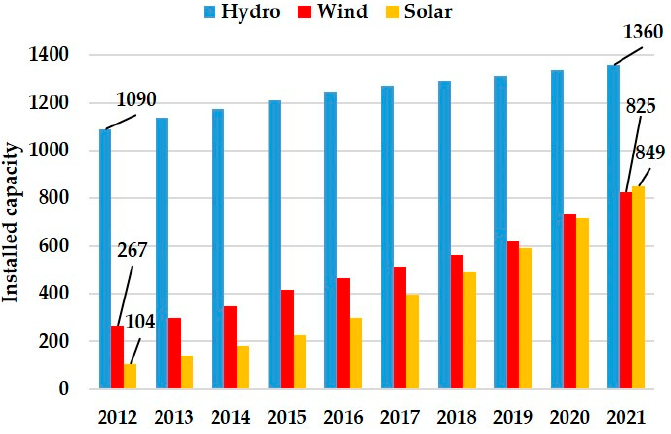
Figure 1. Renewable energy sources’ installed capacity.